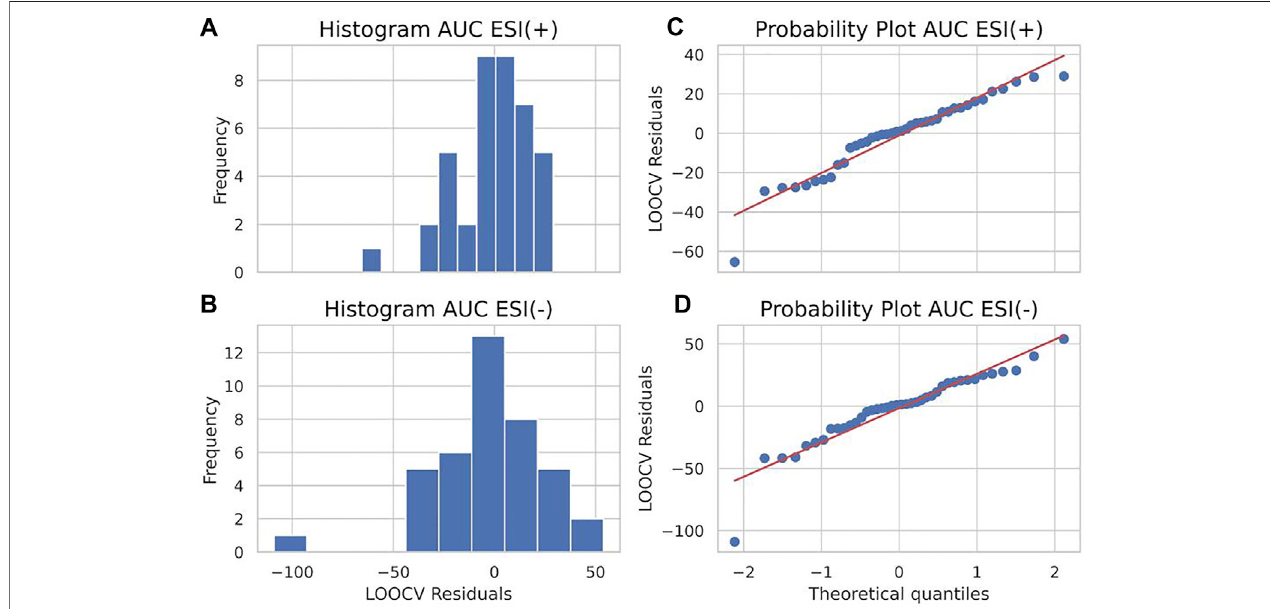
FIGURE5| Ahistogramofresiduals(leftpanels)ofESI(+) (A) andESI( − ) (B) dataandprobabilityplotofresiduals(rightpanels)ofESI(+) (C) andESI( − ) (D) datafor area under curve (AUC) predictions.